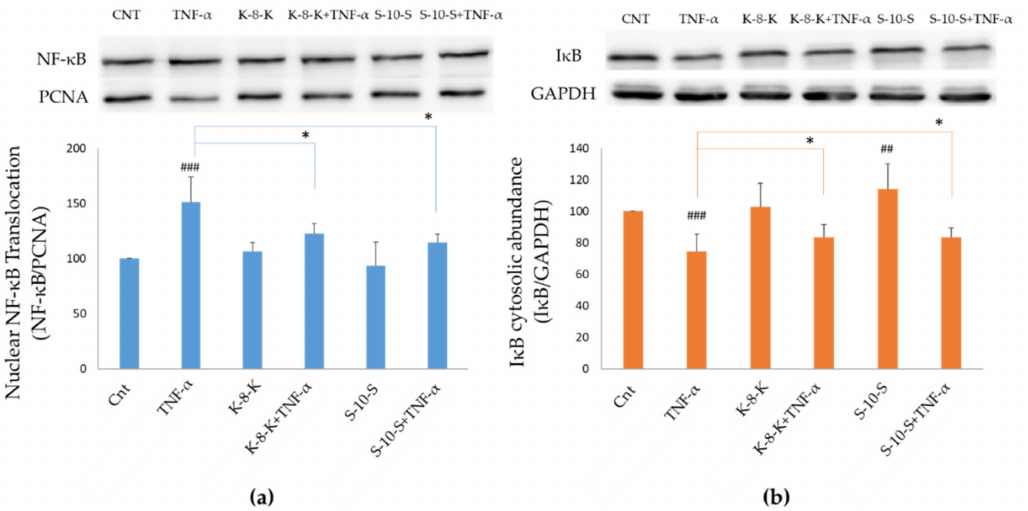
Figure 3. Evaluation of the levels of NF- κ B and I κ B. Caco-2 cells were preincubated with 0.05 mg/mL peptides for 24 h, and the inflammatory stimulus was induced with 2 ng/mL TNF- α for 2.5 h. Western blot analysis of the abundance of NF- κ B in nuclear fractions ( a ) and cytosolic I κ B ( b ) was performed. Densitometric estimation of the reported WB was carried out using PCNA or GAPDH as the loading control for the nuclear and cytosolic compartments, respectively. Means of at least three experiments were compared. ### p < 0.001, ## p < 0.01 vs. nontreated group (Cnt); * p < 0.05 vs. only TNF- α -treated group.